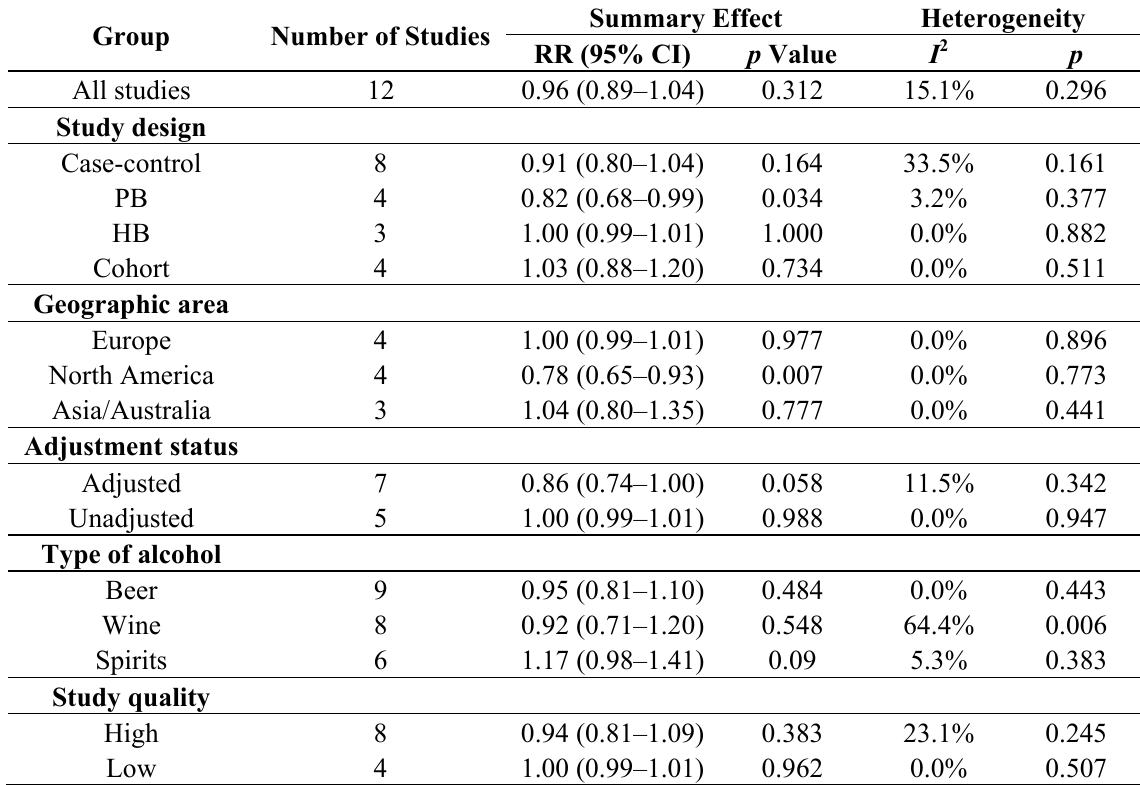
Table 2. Results of meta-analysis for alcohol consumption and risk of